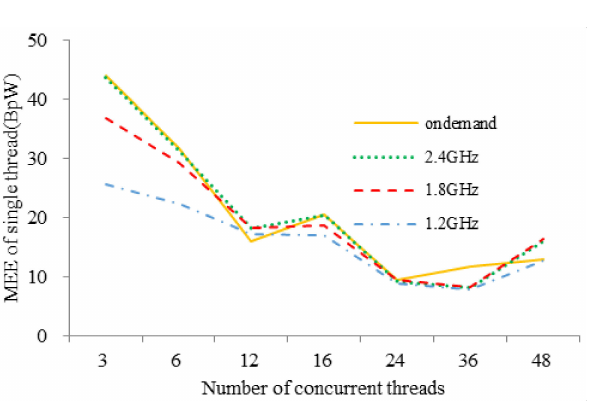
Figure 6. Average memory energy efficiency of single thread with array size = 4 GB (MB/s) on server #2.